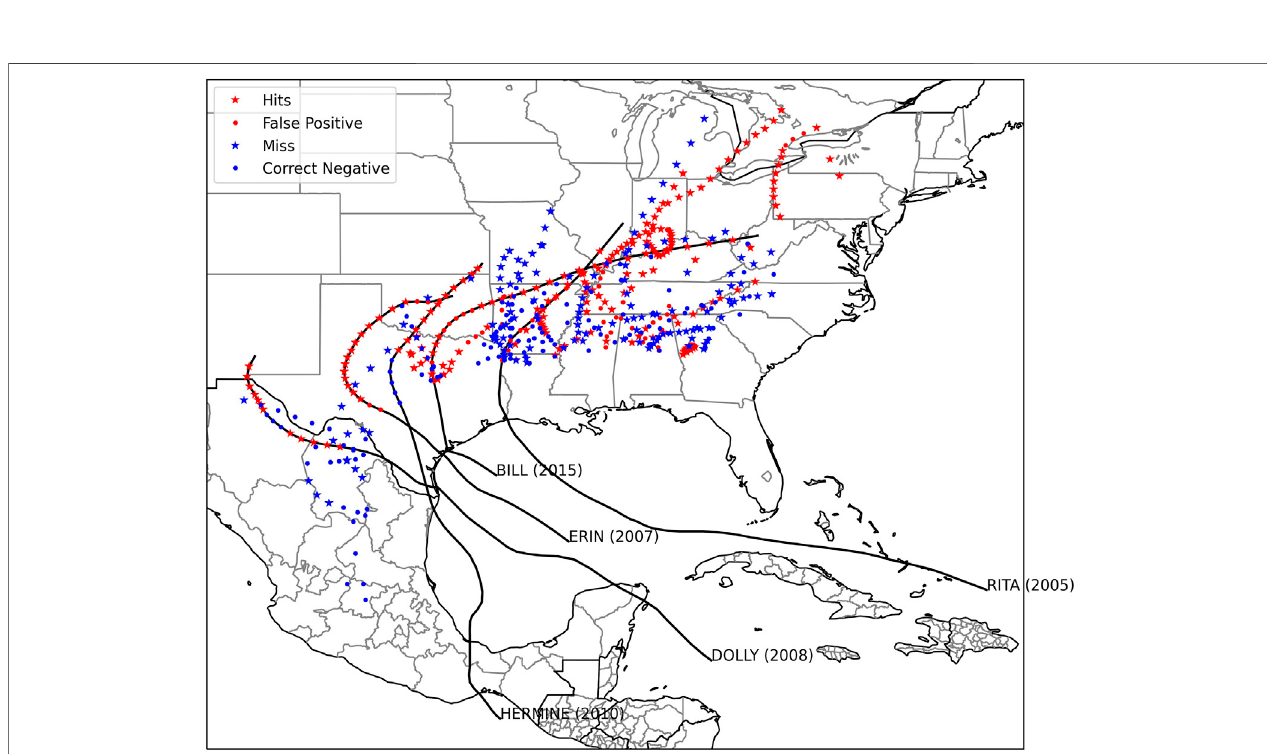
FIGURE 6 | Map of the performance of the machine-learning model. Tropical Storms Bill (2015) and Erin (2007) have been identi fi ed as TCMI events, while Hurricane Dolly (2008)and Tropical Storm Hermine (2010)are described in the text.